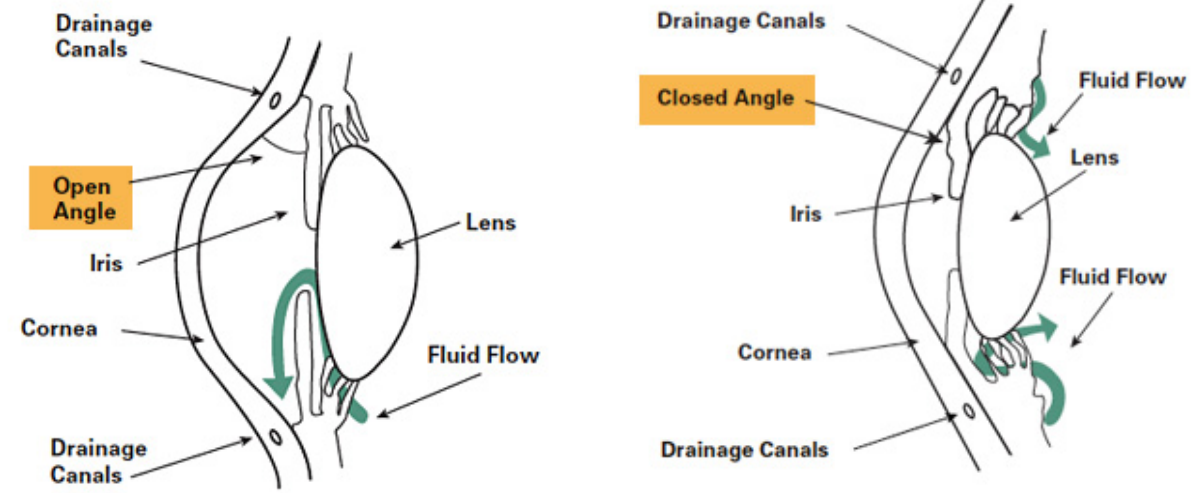
Figure 1. Difference between open angle glaucoma and closed angle glaucoma in relation to the drainage systems within the anterior chamber of the eye. [Images reprinted with permission from the Glaucoma Research Foundation,